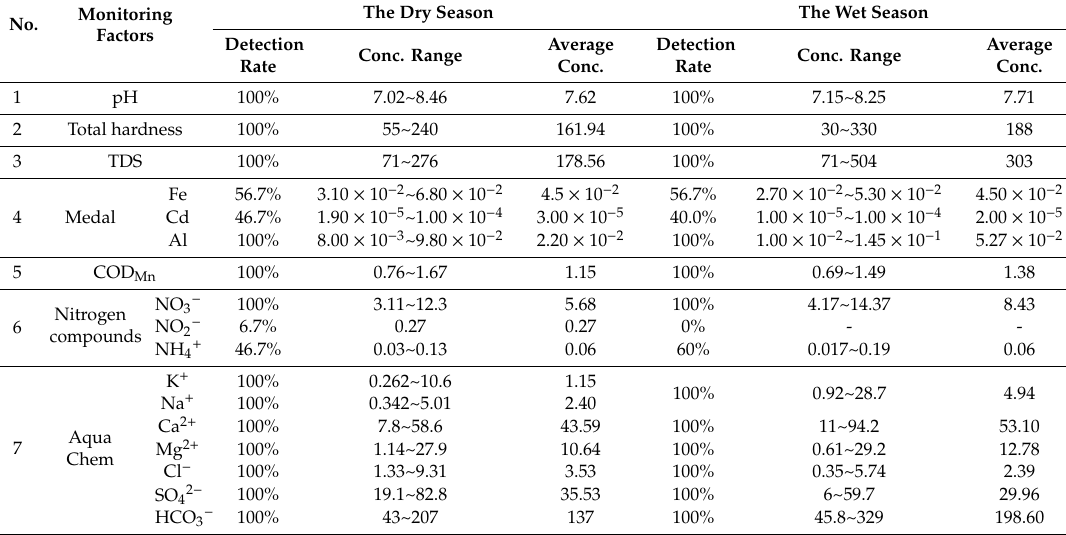
Table 4. Hydrochemical characteristics of